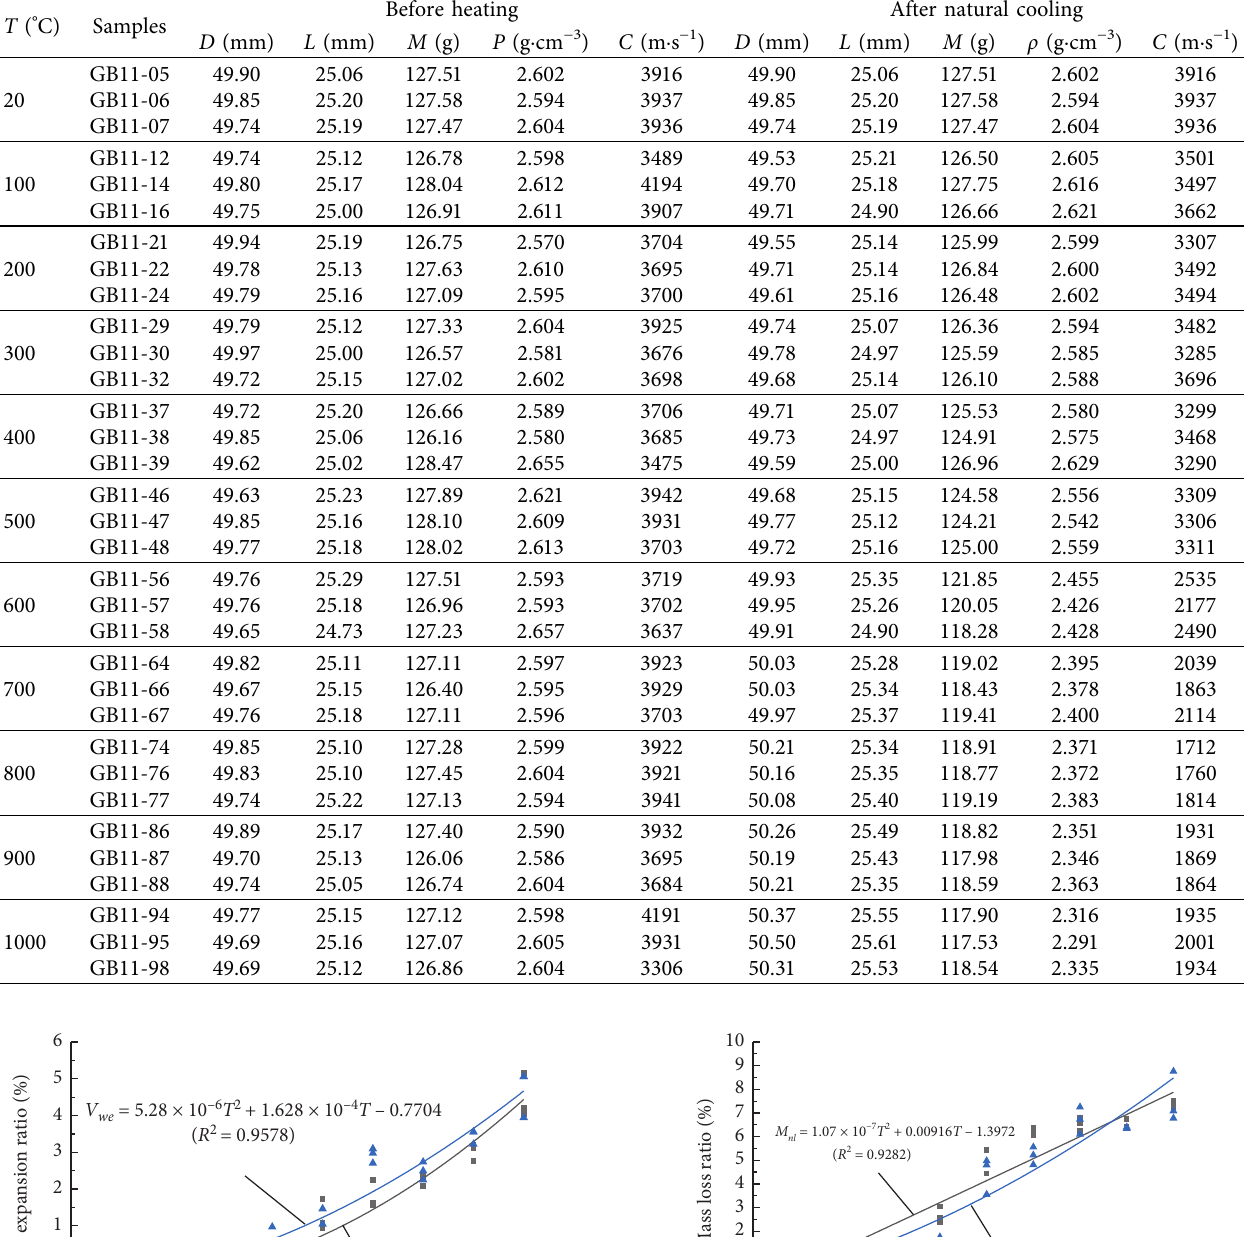
Table 2: Basic physical parameters of sandstone before heating and after natural cooling.